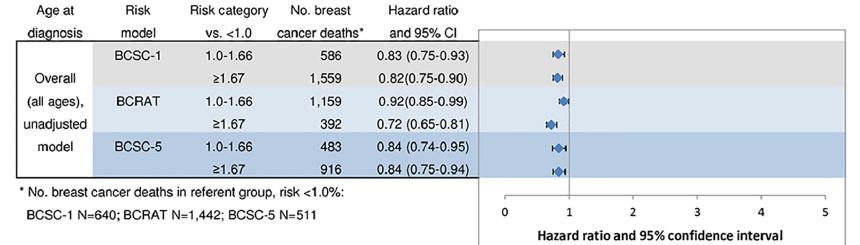
Fig 3. Predicted risk of developing breast cancer versus risk of death